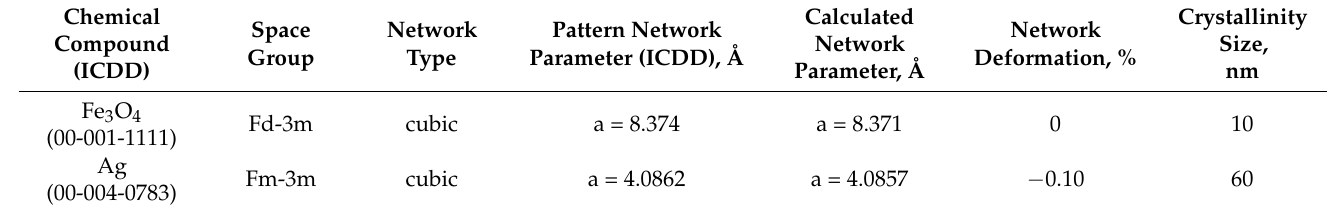
Figure 12. XRD diffractogram of the obtained Fe 3 O 4 @Ag nanoparticles. In Table 1, the information obtained as a result of the XRD analysis is presented. Table 1. Parameters determined based on the XRD diffraction patterns of the Fe 3 O 4 @Ag nanoparticles.